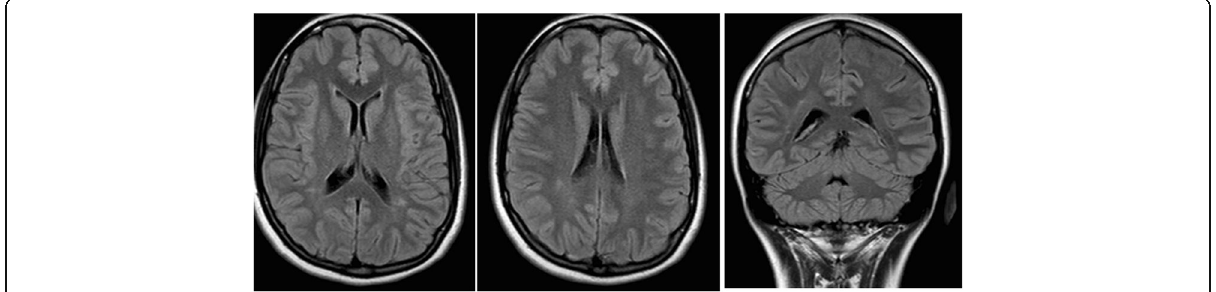
Fig. 1 MRI scan images revealing aspecific peritrigonal white matter hyperintensities. The control MRI was performed after 6 months and 1 year and confirmed the small focal peritrigonal white matter hyperintensities in T2/FLAIR. Hypertension, heart valvular disease and other vasculophaties were excluded. Transcranial doppler US no detected the micro-embolic signals. Another MRI was performed after 2 years and the picture is